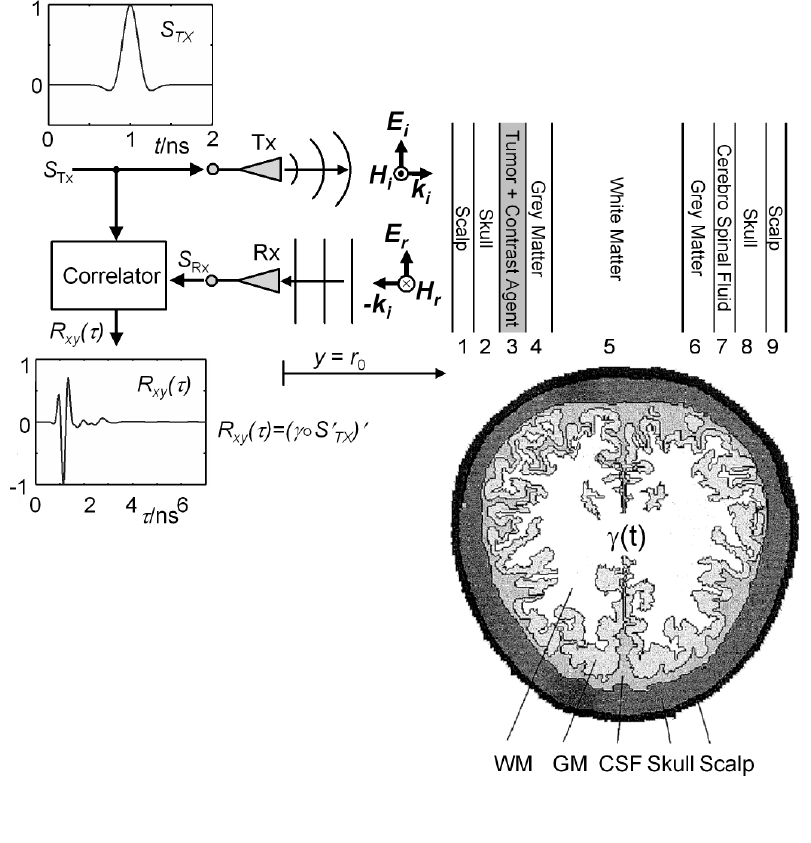
Figure 11. The human head probed by a bi-static set-up. Intracranial tumour in layer 3. WM/GM: white/grey matter, CSF: cerebro-spinal fluid, T x/ R x: transmit/receive